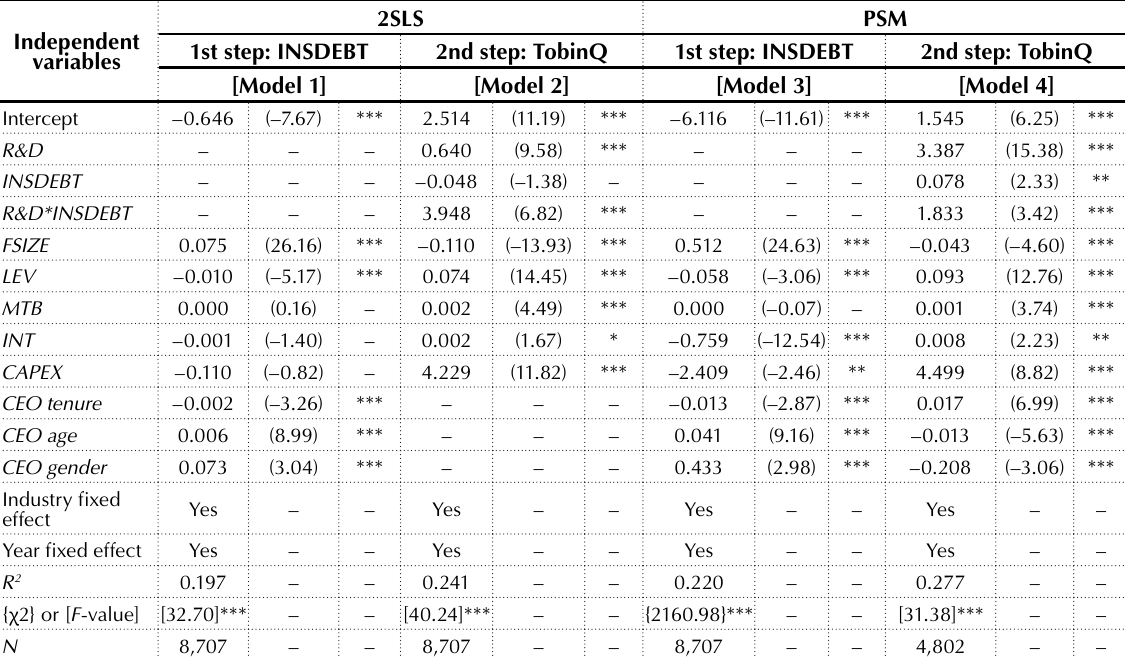
Table 4. Addressing